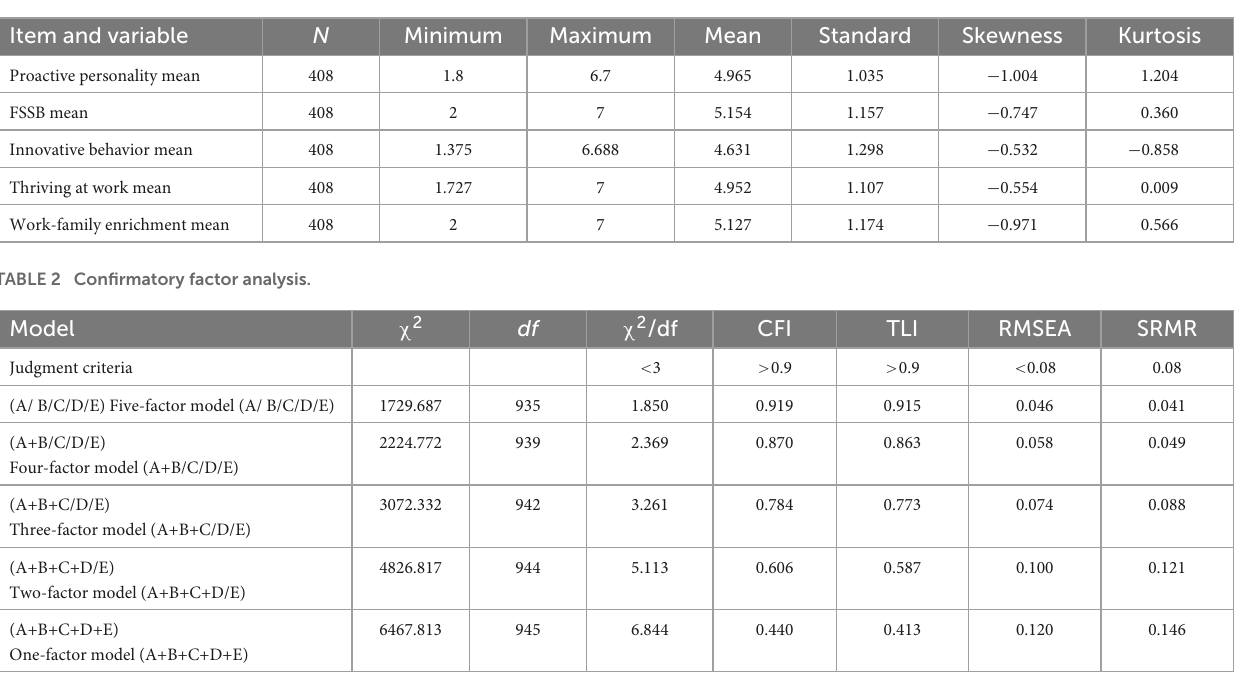
TABLE 1 Description statistics of measurement tools.